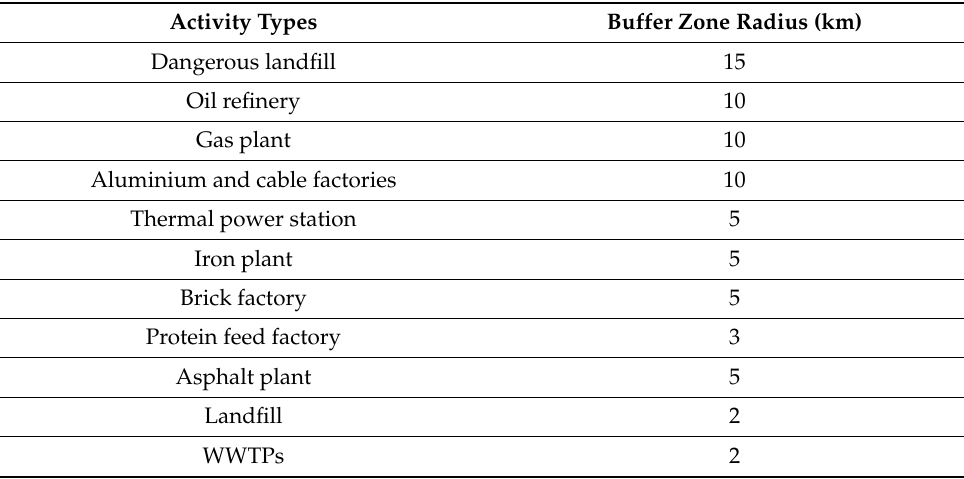
Table 1. Samples of high-polluting projects (Class